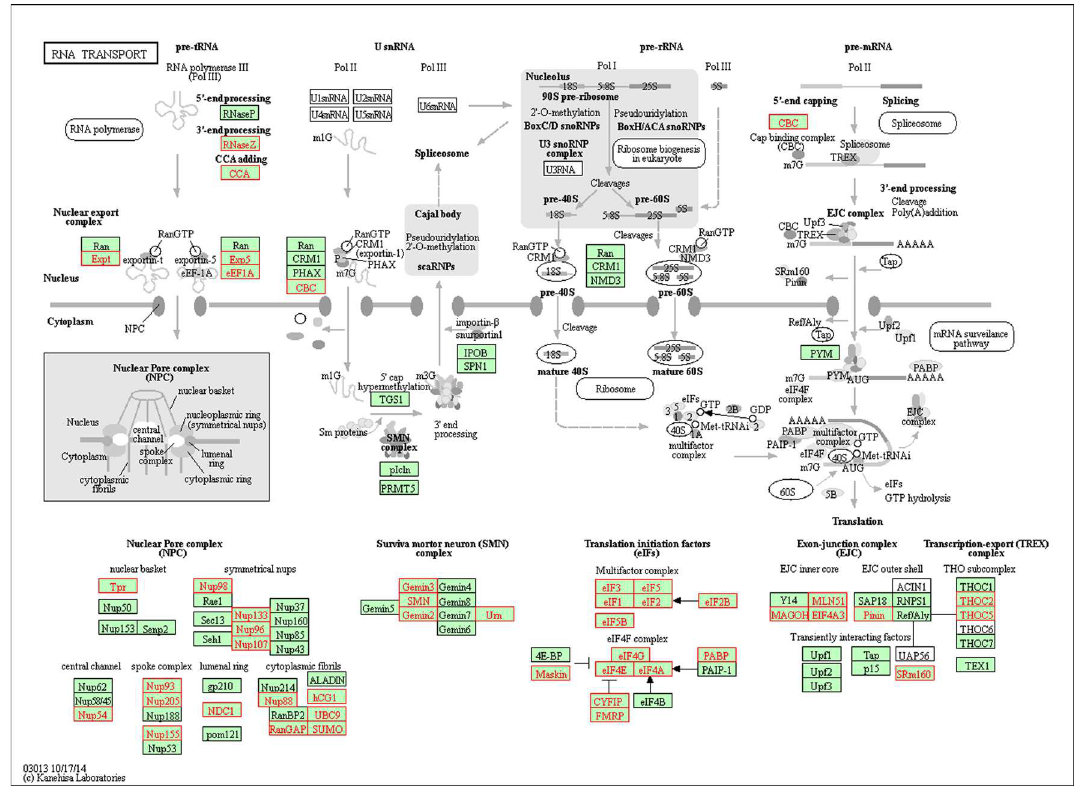
Fig 9. Differentially spliced genes (colored red) associated with the RNA transport pathway.